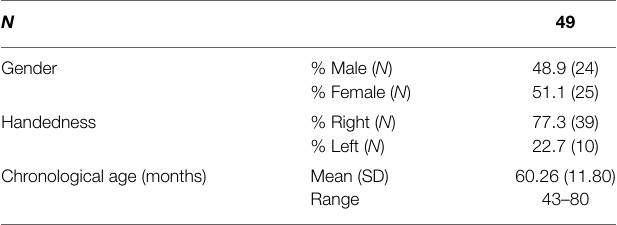
TABLE 1 | Sample size and demographic characteristics of sample .